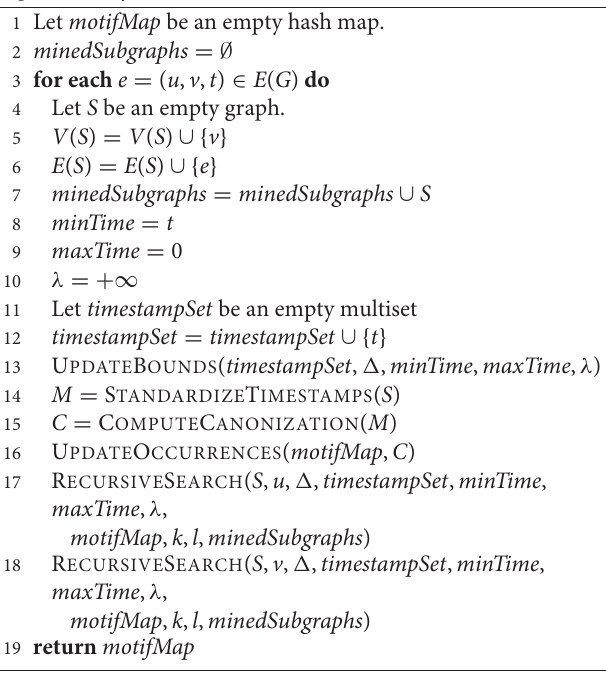
Algorithm 1 | MODIT( G , 1 , k , l ).